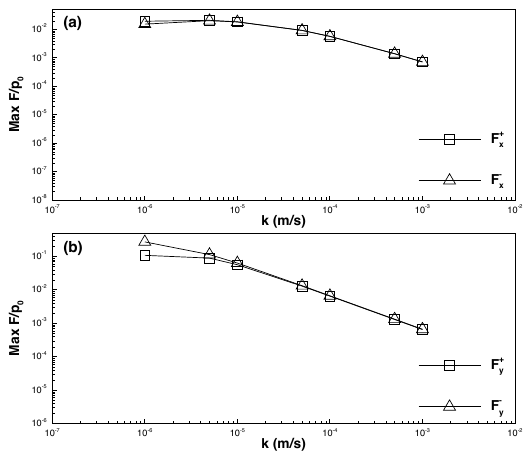
Figure 20. Maximum force on the pipeline in relation to soil permeability; E = 1.0 × 10 7 kPa. ( a ) Horizontal component; ( b ) vertical